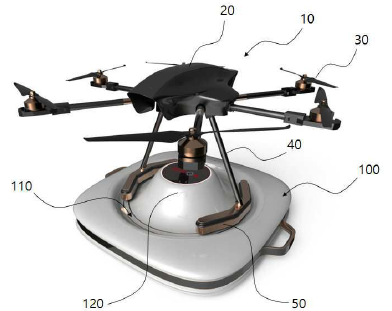
Figure 29. Automatic charging system with a funnel for an unmanned aircraft with ski-type legs [80] . 10, UAV; 40, legs; 50, chassis: 100, docking station; 110, landing groove; 120, central ledge.